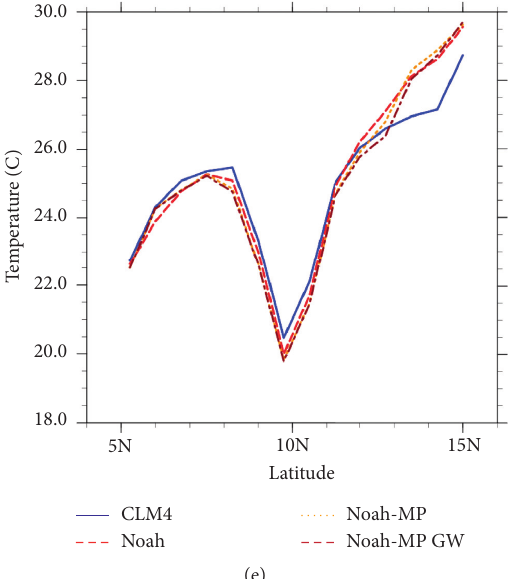
Figure 20: (a) Sensible heat, (b) latent heat, (c) evaporation fraction, (d) soil moisture, and (e) temperature, averaged over the longitudinal extent of the red box in Figure 1 for the JAS